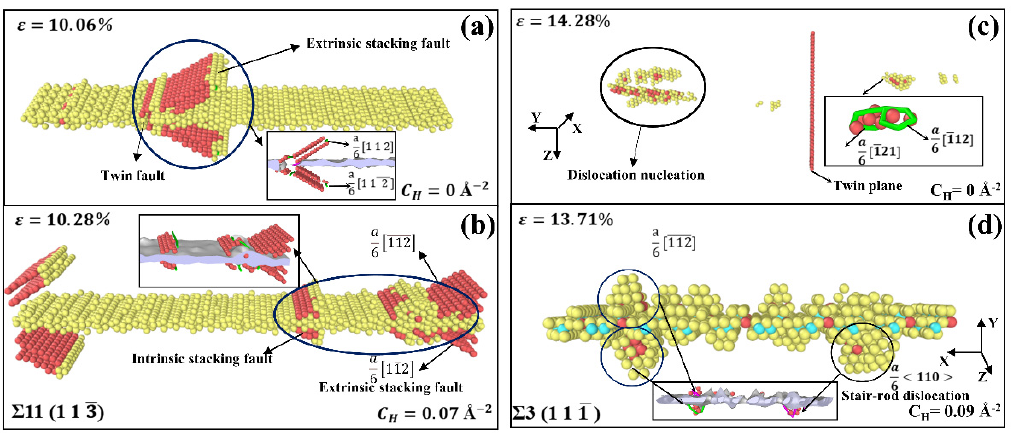
Figure 10. MD snapshots of dislocation nucleation from Ni bicrystal with ( a , b ) Σ 11 ( 1 1 3(cid:3364) ) STGB and ( c , d ) Σ 3 ( 1 1 1(cid:3364) ) STGB without and with H.